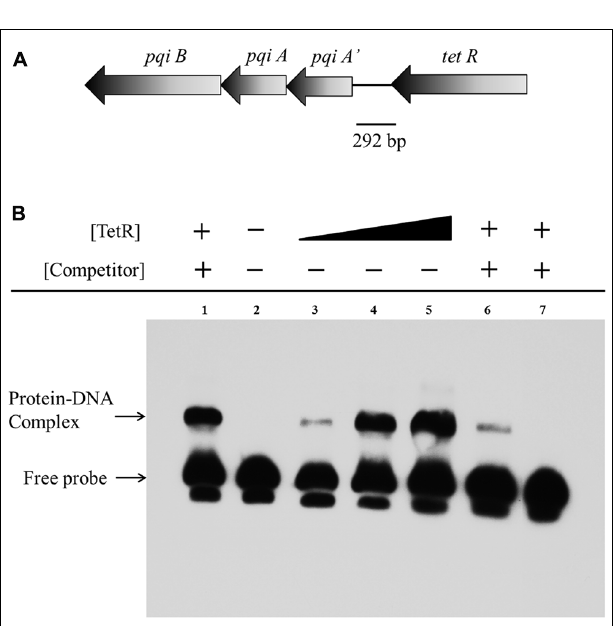
cells exposed to the oxidative compounds for 10 min. Error bars indicated standard deviations from three independent experiments. Different letters indicated significant differences ( P < 0.05) among treatments.